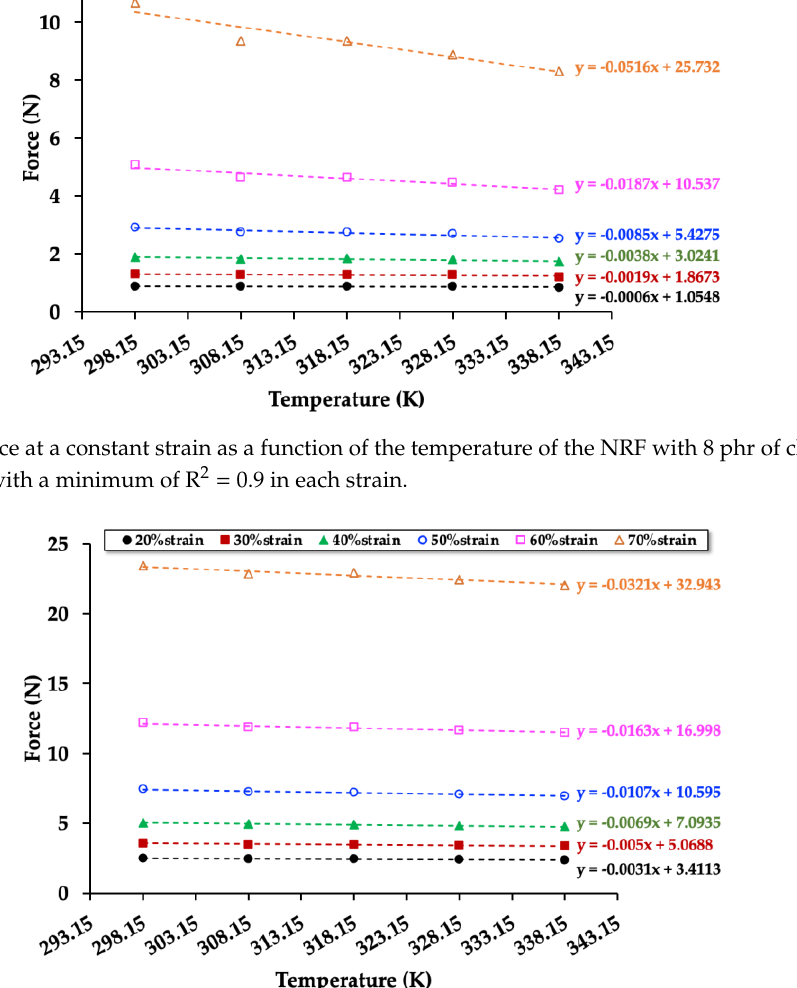
Figure 9. Force at a constant strain as a function of the temperature of the NRF with 8 phr of silica (NRF / 8 Si) with a minimum of R 2 = 0.9 in each strain.